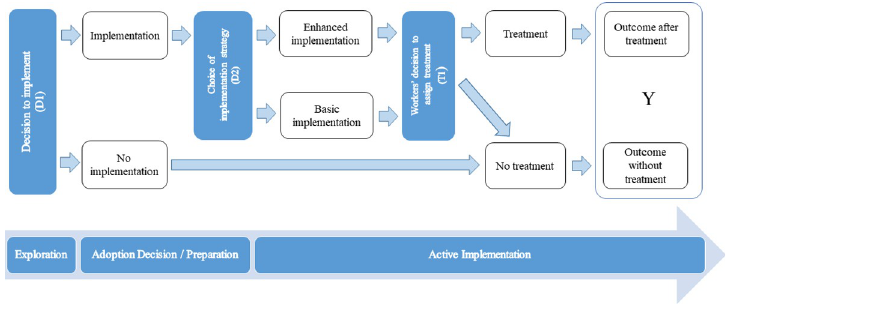
Fig 3. Flow chart for a hypothetical study of the implementation of